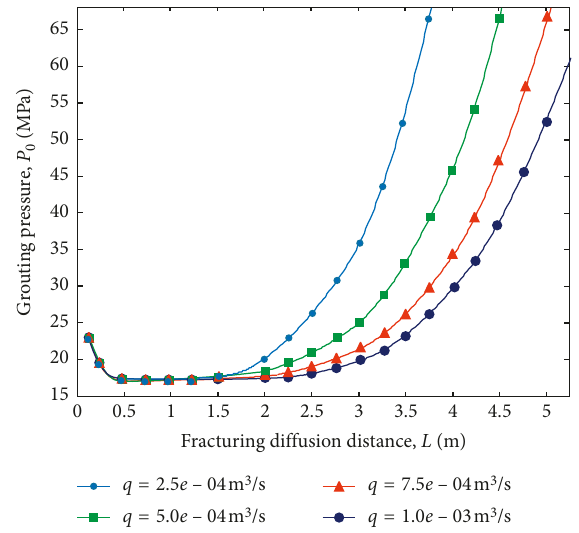
Figure 8: Influence of the grouting flow rate on the fracture diffusion